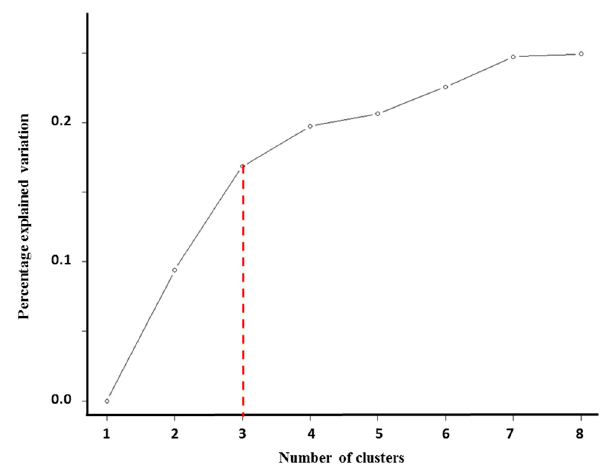
Figure 2. Optimization of cluster number. To assess the number of clusters we plotted the number of tested clusters vs. percent of explained variation. Optimal k or cluster number is the point at which percent of explained variation begins to level off after initial rapid ascent. Here, k = 3 [15].